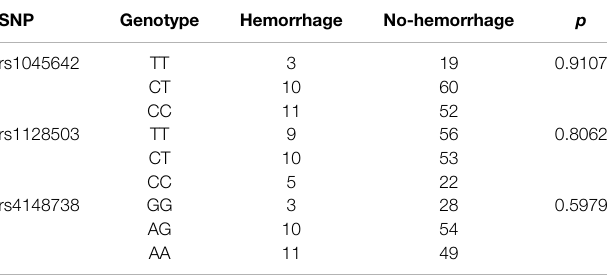
TABLE 8 | ABCB1 SNPs and bleeding